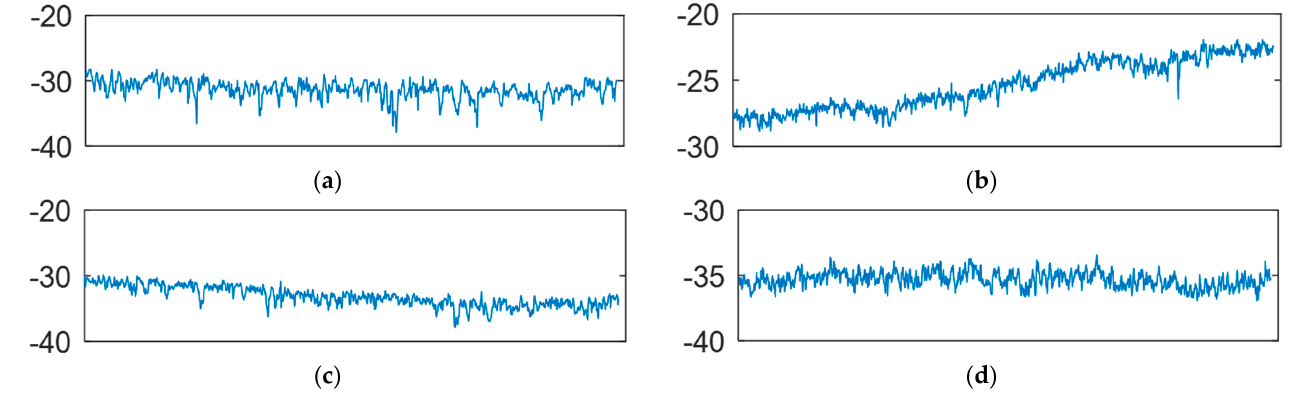
Figure 1. 2D texture profiles of different pavements: ( a ) Stone Matrix Asphalt (SMA), ( b ) Portland cement concrete (PCC), ( c ) asphalt concrete (AC), and ( d ) High Friction Surface Treatments (HFST).